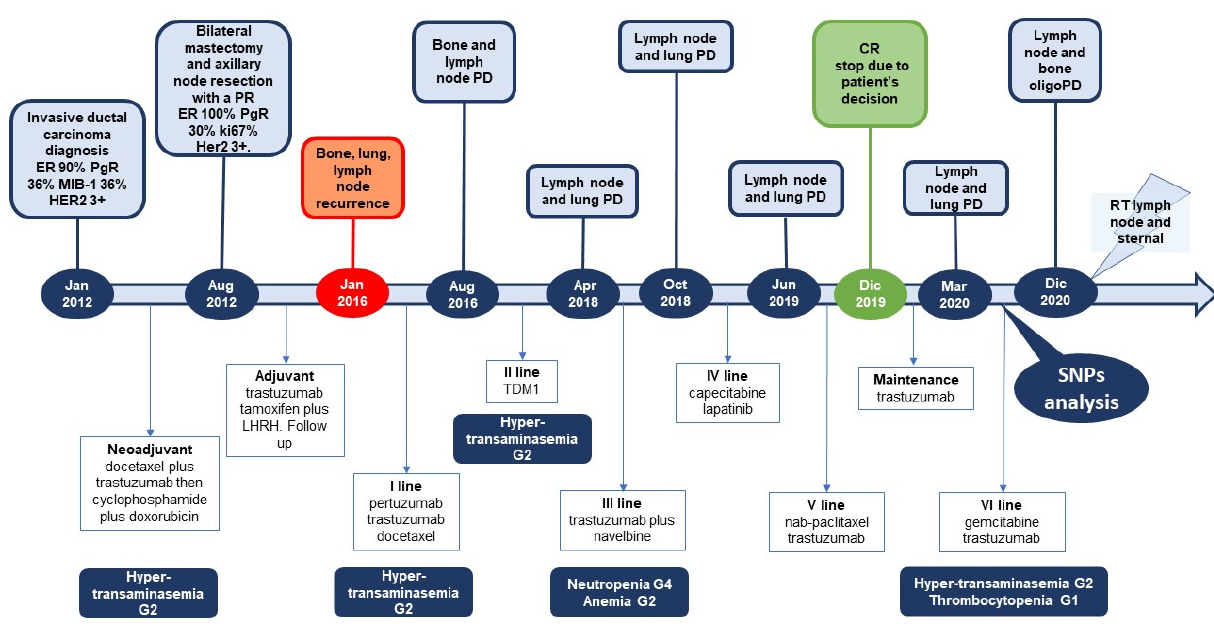
Figure 2. Timeline of patient’s clinical history and toxicity reported in treatment lines. Legend: ER, estrogen receptor; PgR, progesterone receptor; HER2, human epidermal growth factor receptor 2; LHRH, luteinizing hormone-releasing hormone; PD, progression disease; CR, complete response; RT, radiotherapy; SNPs, single nucleotide polymorphisms.